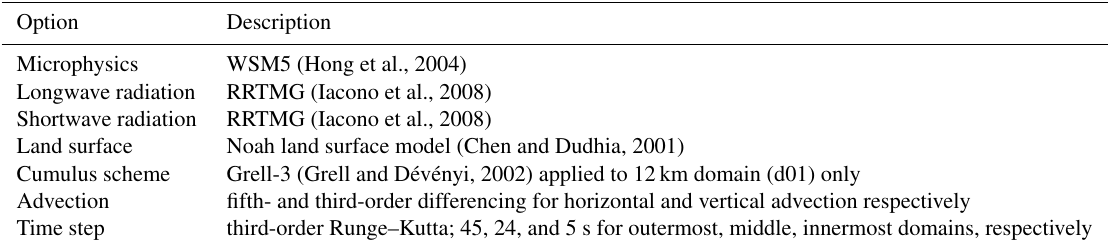
Table 1. Common elements of the WRF-Chem configuration used in all runs.